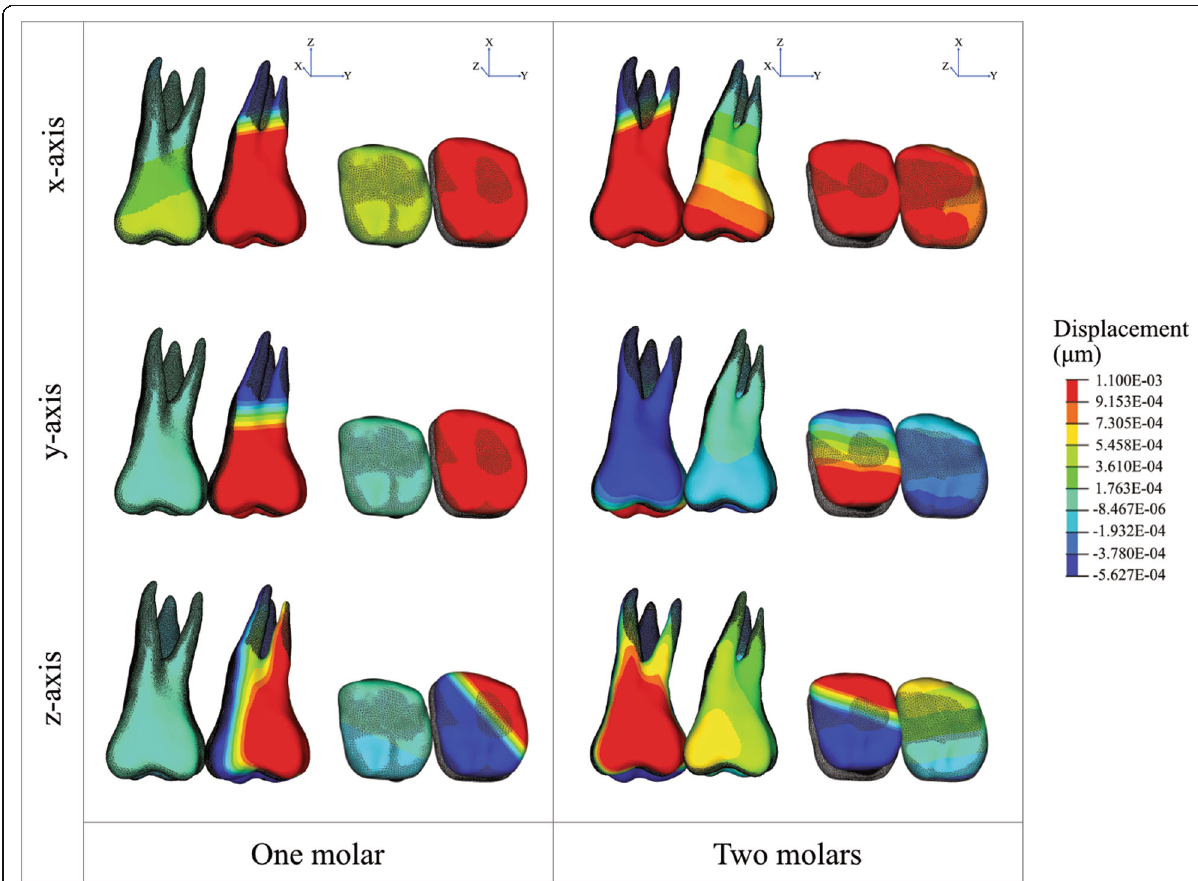
Fig. 5 Contour image of the displacement of a one molar distalization, b two molars distalization in x- , y- , and z -axes. The black mesh showed the original position. The color image shows the movement of the teeth after applied 200 g distalization (× 200 times